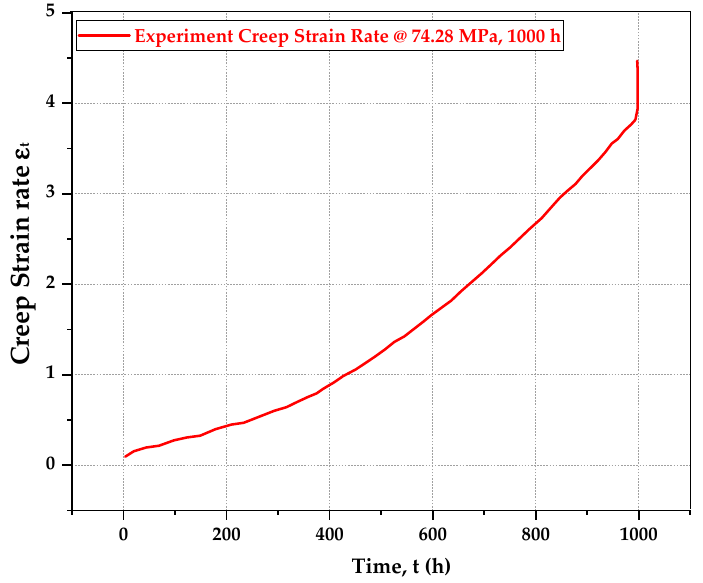
Figure 12. Creep strain rate for 1000 h test, 60% yield strength, 74.28 MPa, and 720 °C.